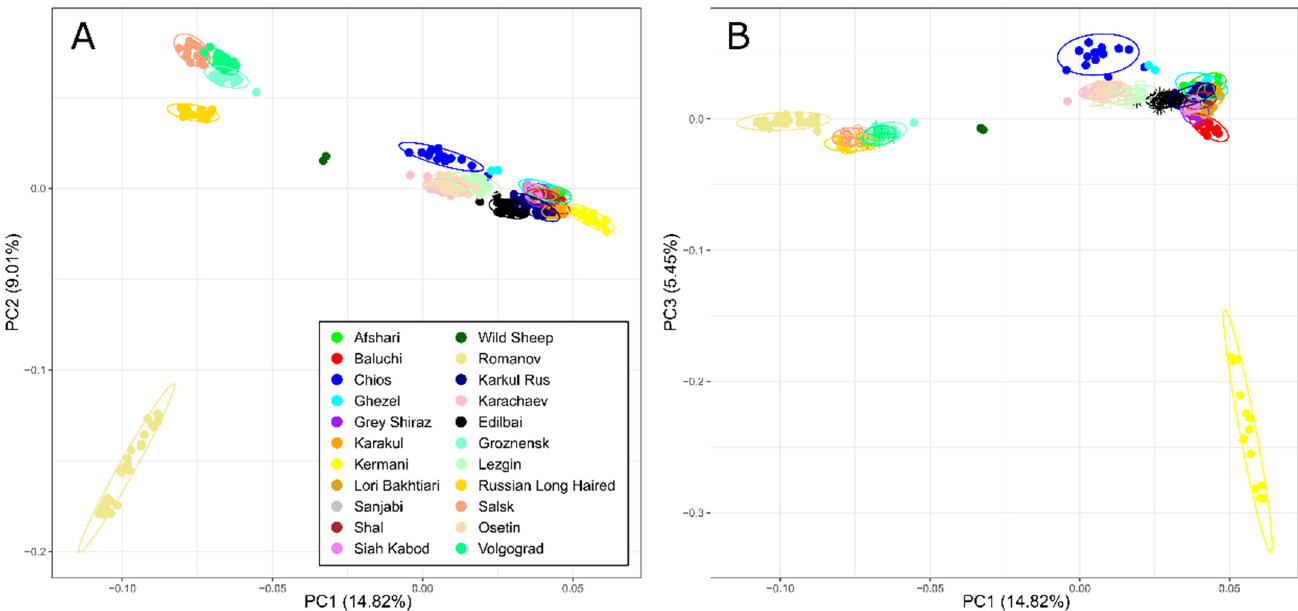
Figure 1. Principal Component Analysis for Iranian and Russian sheep breeds performed: ( A ) for the first two principal components (PC1 and PC2); ( B ) and for the first and third principal components (PC1 and PC3).